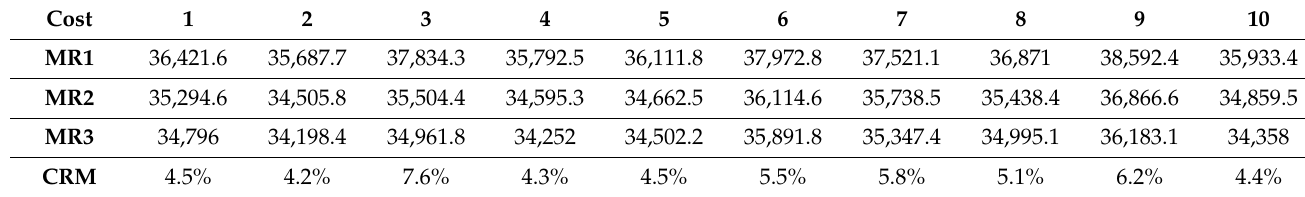
Table 7. Computational results of the third instances set in Case 1.